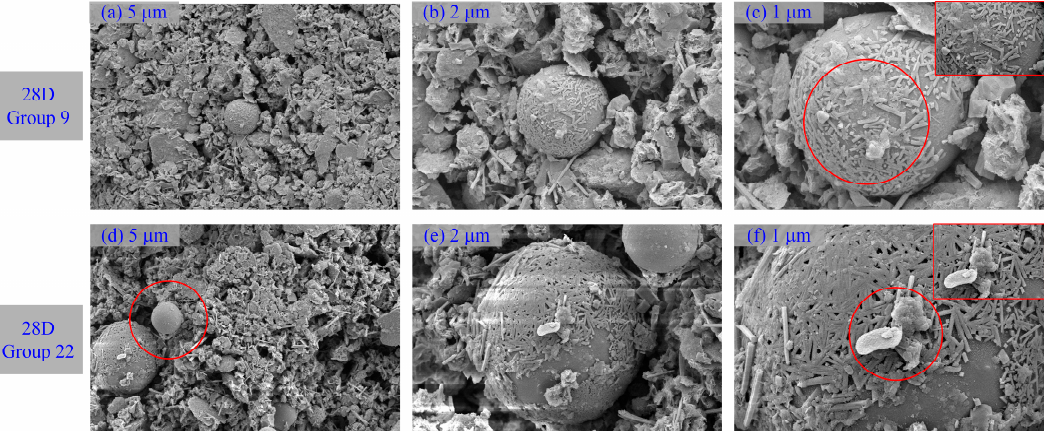
Figure 16. SEM photomicrographs of DWS-GM with 28 days of curing. 28D Group 9: ( a ) 2.0KX ( b ) 5.0KX ( c ) 10.0KX 28D Group 22: ( d ) 2.0KX ( e ) 5.0KX ( f ) 10.0KX.